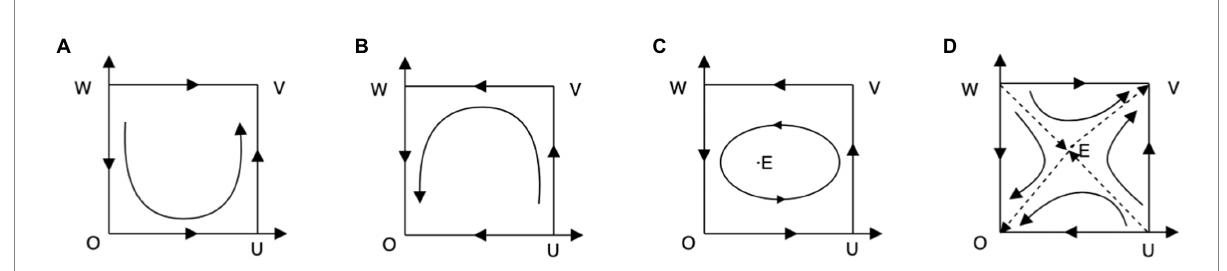
FIGURE 3 Phase diagram of system evolution for